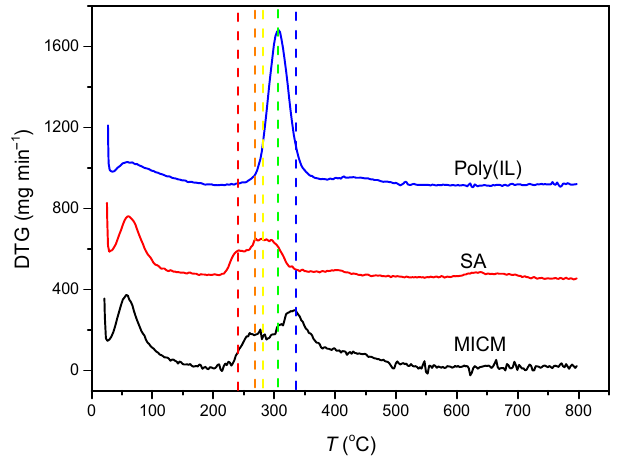
Figure 2. Differential thermal gravimetric (DTG) analysis of the membranes. In Figure 3, the two characteristic absorption peaks of SA at 1638 and 1434 cm − 1 were attributed to asymmetric and symmetric stretching of the carboxylate group − COO − , respectively [25]. The peak of poly(IL) at 1691 cm − 1 was attributed to C = O stretching vibration; the peak at 1546 cm − 1 was assigned to the skeleton vibration of the imidazole ring of the IL; and the peaks at 1397 cm − 1 was due to the stretching vibration C − N [26]. The infrared spectrum MICM was the rough superposition of the infrared spectra of CA